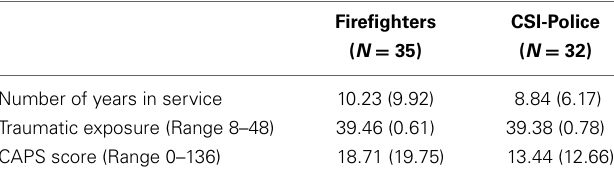
Table 2 | Trauma exposure and PTSD symptoms (mean and standard deviation) of firefighters and CSI